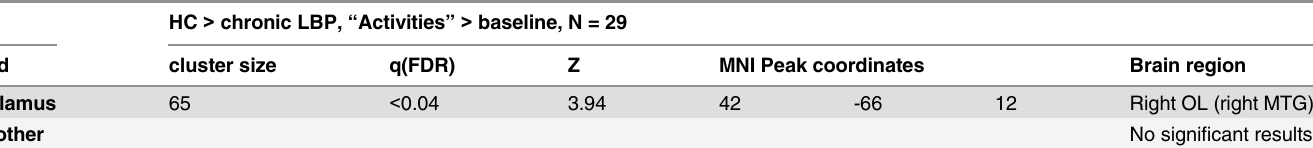
Table 5. Functional connectivity cluster maxima of the healthy controls (HC) vs. chronic Low Back Pain (LBP) group, contrast activities of daily liv- ing ( “ Activities ” ). All results are false discovery rate corrected (FDR, q < 0.05). MNI = Montreal Neurological